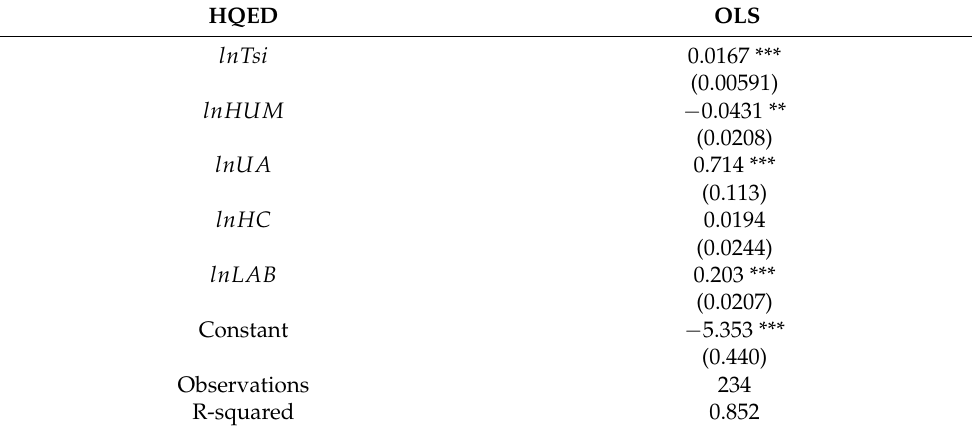
Table 5. Results of the nonspatial panel model. HQED